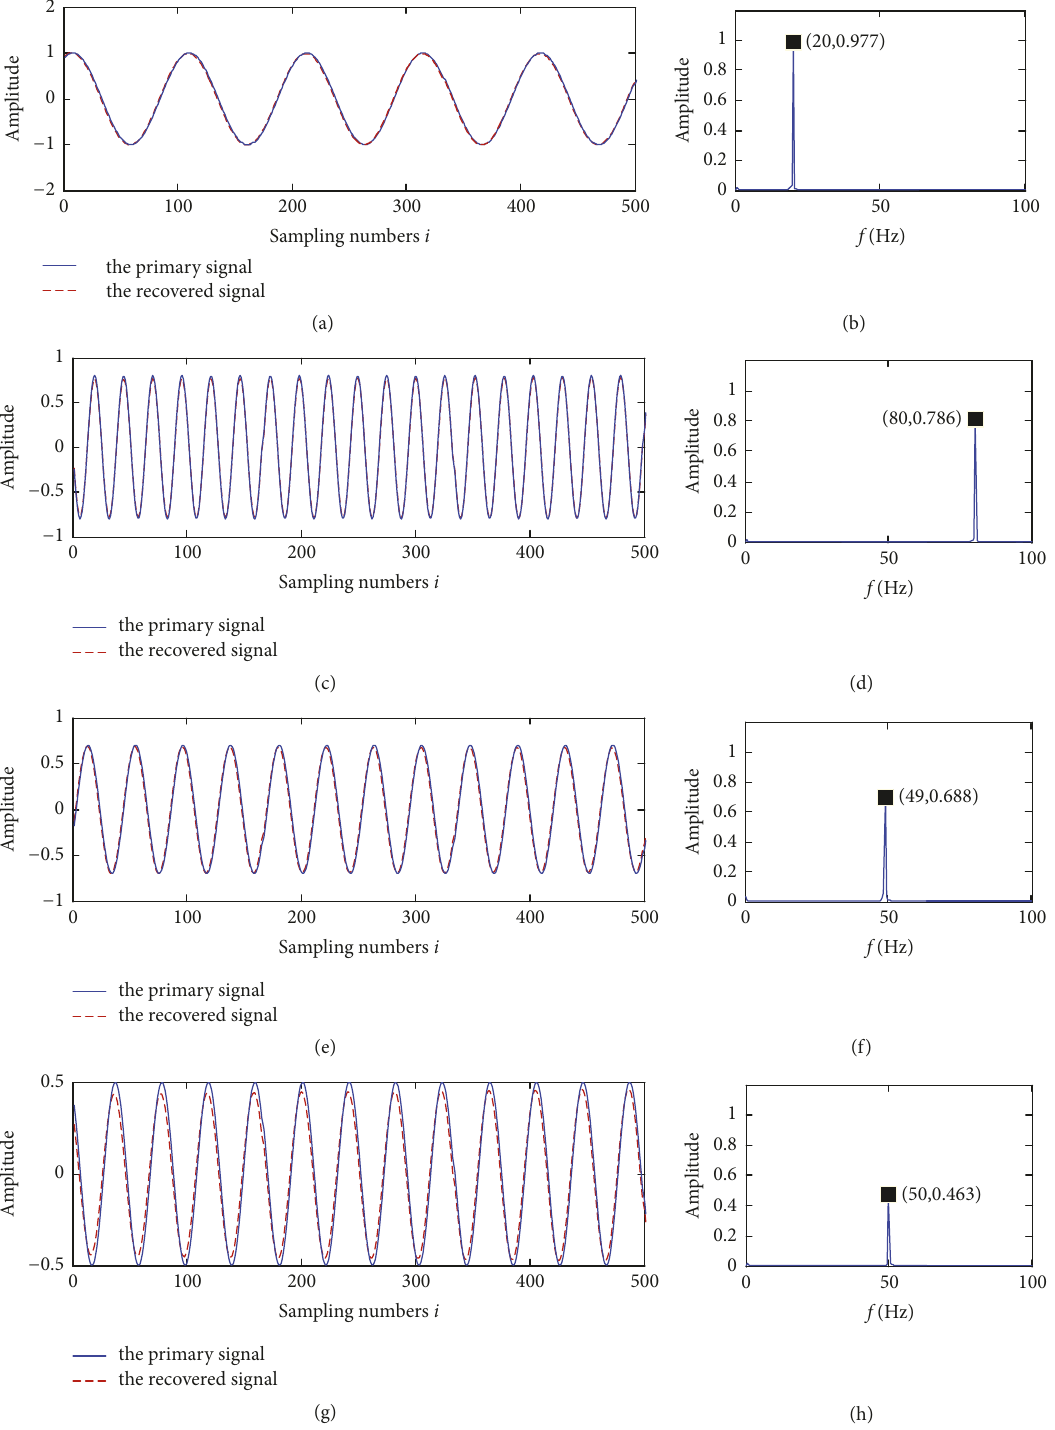
Figure 6: The time and frequency domains of reconstructed signal. (a) The time domain of the reconstructed signal via the first set of eigenvalues. (b) Amplitude spectrum of Figure 6(a). (c) The time domain of the reconstructed signal using the second set of eigenvalues. (d) Amplitude spectrum of Figure 6(c). (e) The time domain of the reconstructed signal using the third set of eigenvalues. (f) Amplitude spectrum of Figure 6(e). (g) The time domain of the reconstructed signal using the fourth set of eigenvalues. (h) Amplitude spectrum of Figure